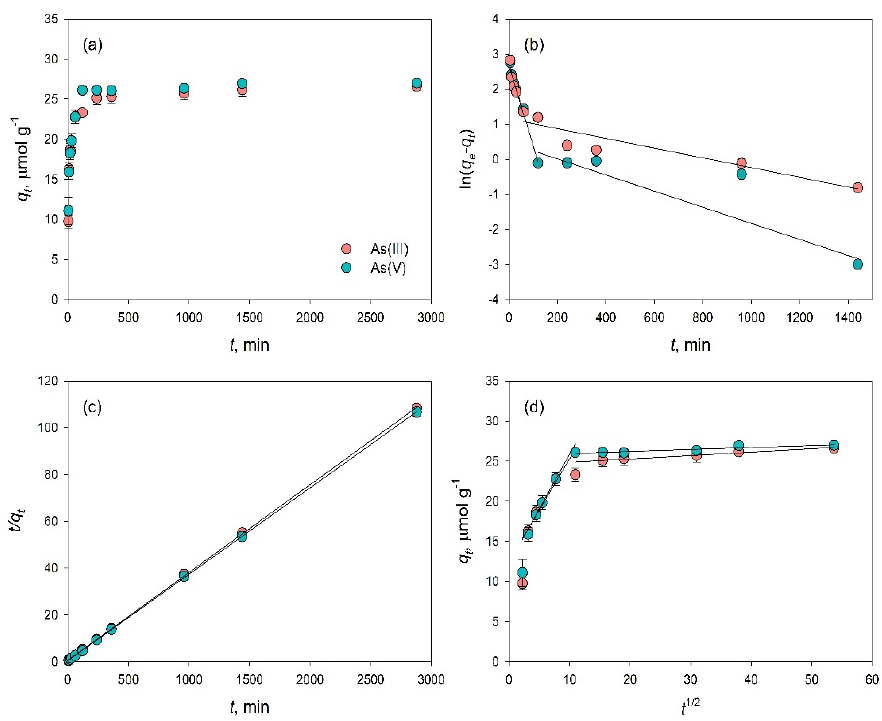
Figure 5. Kinetics of As(III) and As(V) adsorption on Bi 2 O 3 (4 g/L) at pH 8 and 7, respectively, and 25 ± 3 °C: variation of q with time ( a ), pseudo-first-order model ( b ), pseudo-second-order model ( c ), and intraparticle diffusion model ( d ). Error bars represent the standard error. Where the error bars are not visible, they are smaller than the size of the symbol. Table 2. Kinetic parameters for the adsorption of As(III) and As(V) on Bi 2 O 3 .